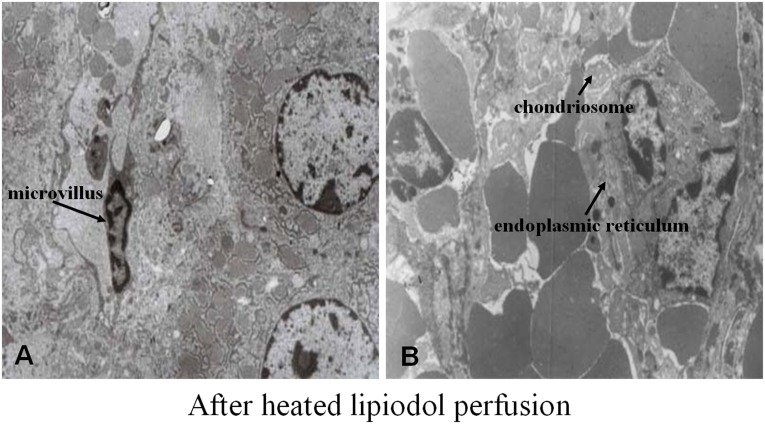
TEM results of treated tumors.Stimulated by heated (60°C) lipiodol perfusion, TEM results revealed that the tumor endothelial cell microvilli decreased (A, 5000×), the vascular endothelial cell endoplasmic reticulum expanded, and the chondriosome was swollen (B, 10000×).